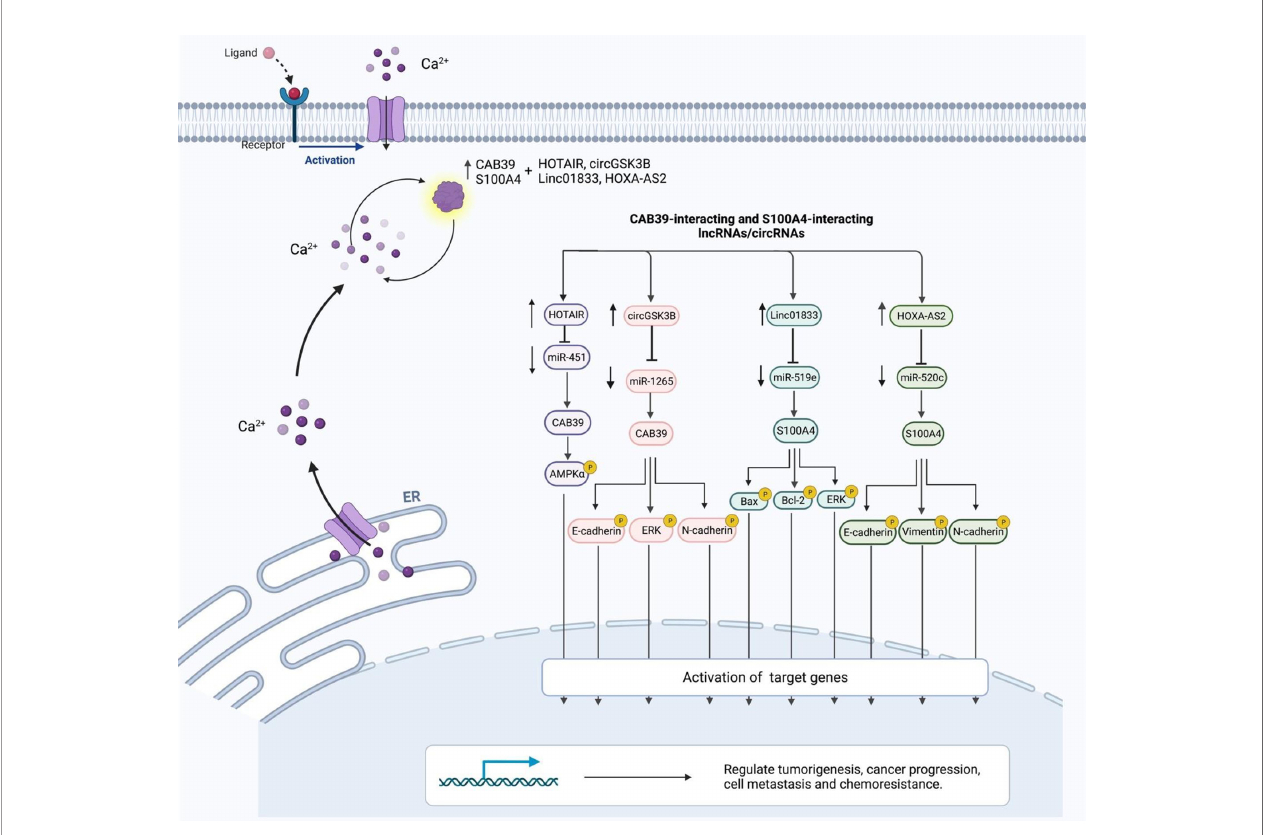
FIGURE 2 | Interaction between CBPs (CAB39 and S100A4) and lncRNAs/circRNAs with their contribution in human disorders.